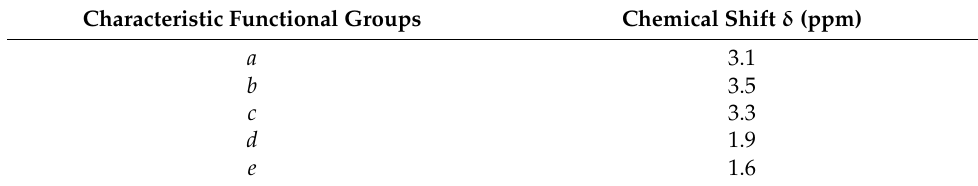
Table 2. 1 HNMR analysis of the synthetic copolyether.